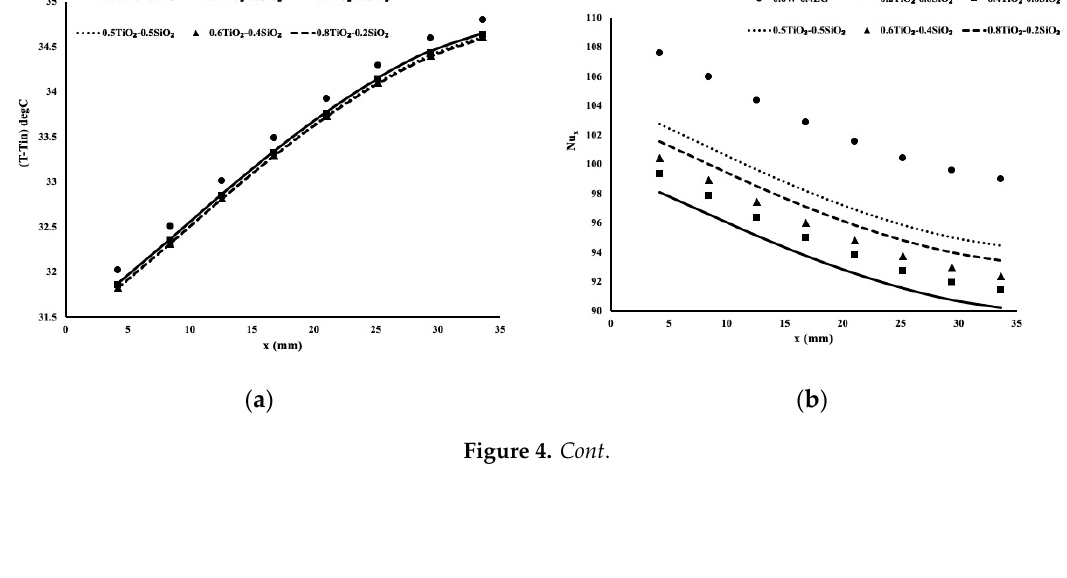
Figure 3. Heat enhancement using the Al 2 O 3 –Cu in water mixture. ( a ) Temperature variation along the flow, ( b ) Nusselt number of each individual mixture, ( c ) Nusselt number using standard definition.